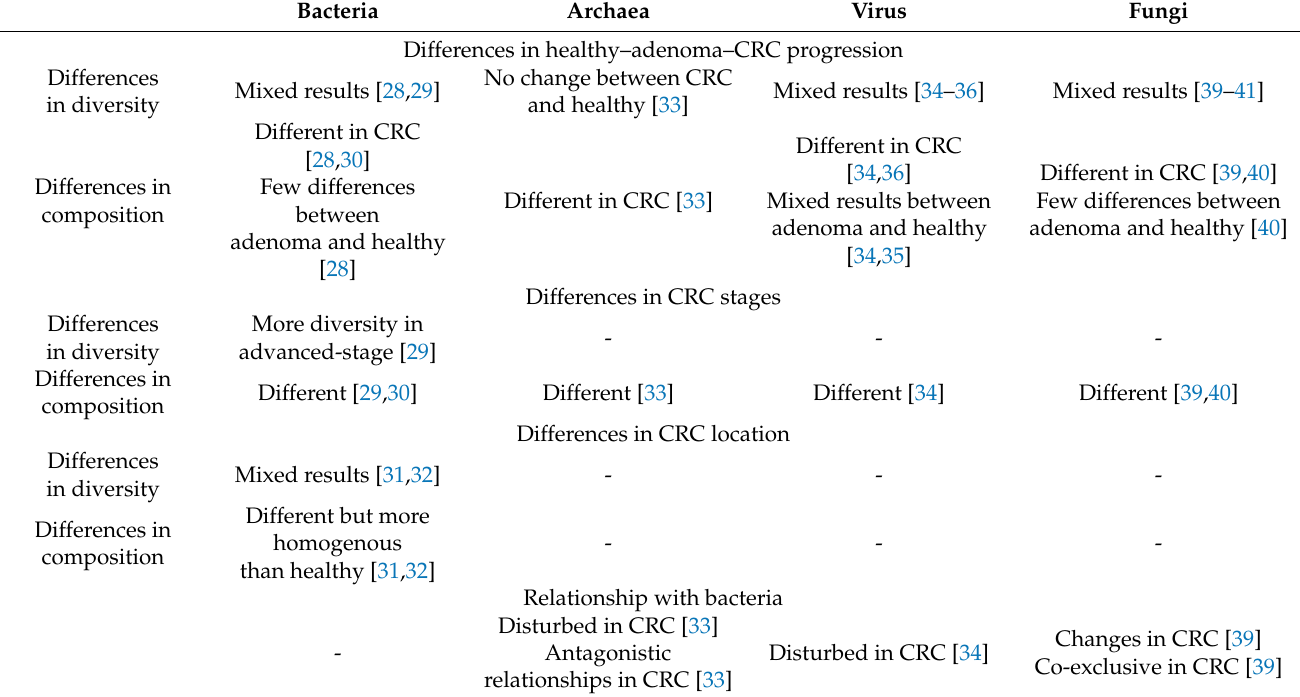
Table 1. Summary of the findings about the components of the